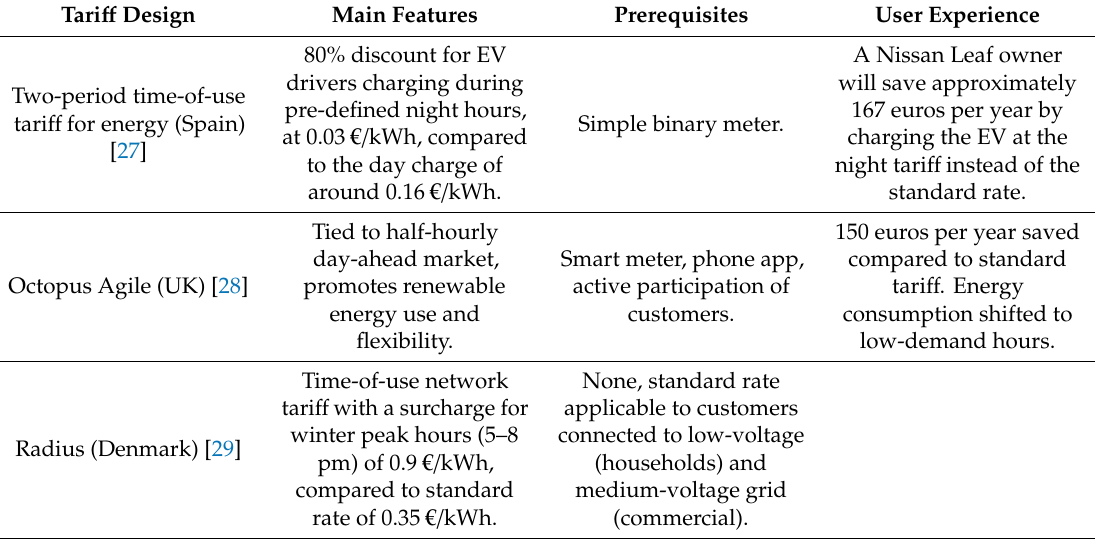
Table 1. Examples of time-varying rate